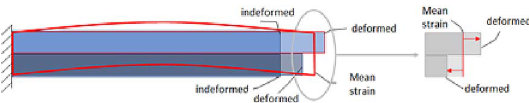
Figure 21. Bending deformation caused in a tube with asym- metry in the cross